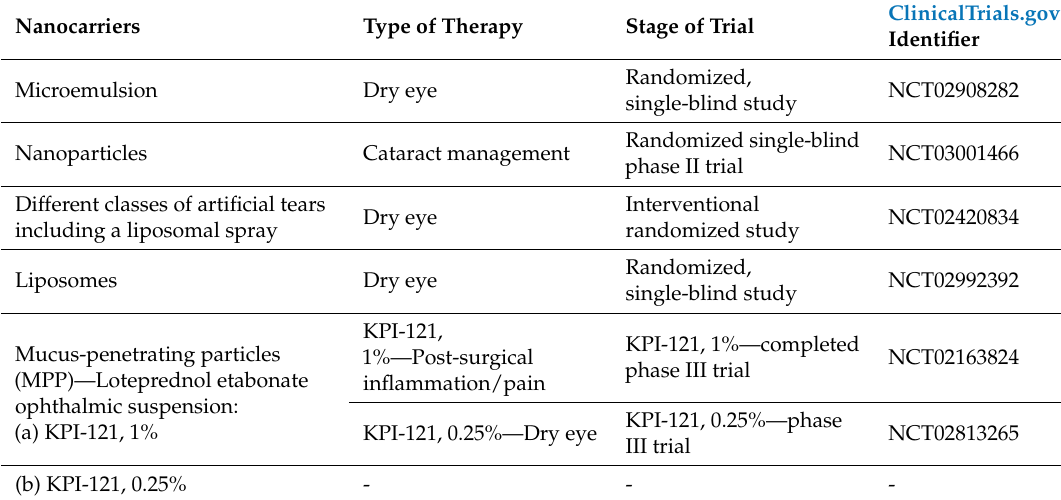
Table 1. Nanocarriers in Clinical